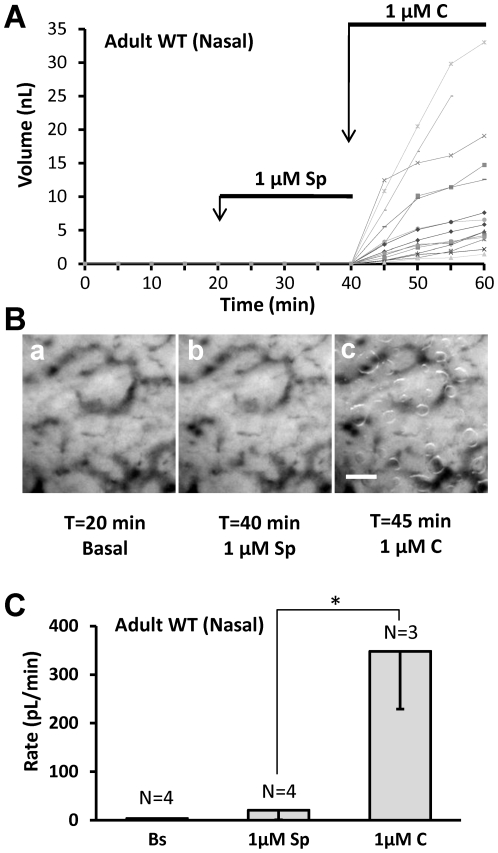
Nasal glands of adult WT pigs show minimal secretory response to SubP.
A, Adult pig responses to SubP. Graph of mucus volume as a function of time and stimulation for 12 glands in fresh tissue from an adult pig. B, Images of mucus bubbles secreted under oil from nasal turbinate mucosa of an adult pig after stimulation with SubP for 20 min followed by carbachol for 5 min. C, Summary data for 3–4 pigs; the responses to SubP did not differ significantly from basal (paired t-test, P = 0.375) and were significantly less than the response to carbachol (t-test, P<0.02).